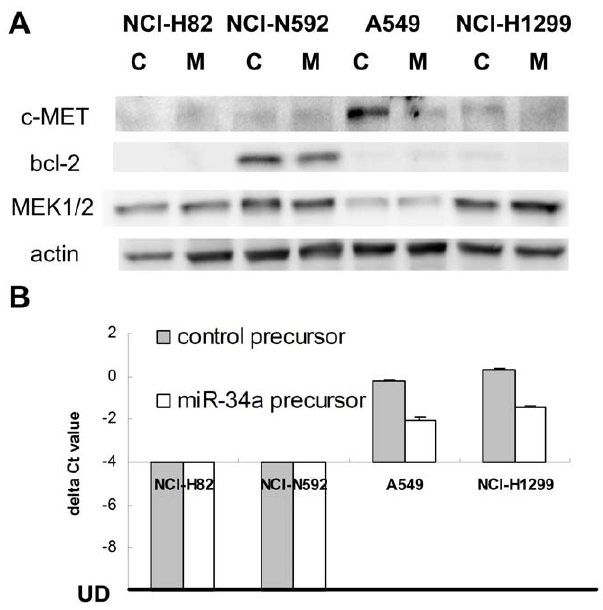
Figure 3. Expression of miR-34a target genes in SCLC and NSCLC cancer cell lines. (A) protein expression of miR-34a targets in cancer cell lines tranfected with control precursor (C) or miR-34a precursor (M). (B) mRNA expression of the AXL gene in cancer cells transfected with control precursor or miR-34a precursor. RNA was collected 24 hr after transfection. The expression of the gene in NCI- H82 and NCI-N592 cells were undetectable (UD).